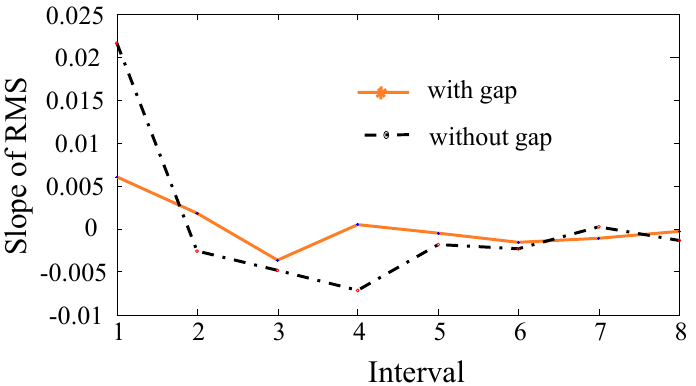
Figure 13. Gradient of AE signals for eight 1 ms intervals for joints with normal and low bonding strength.